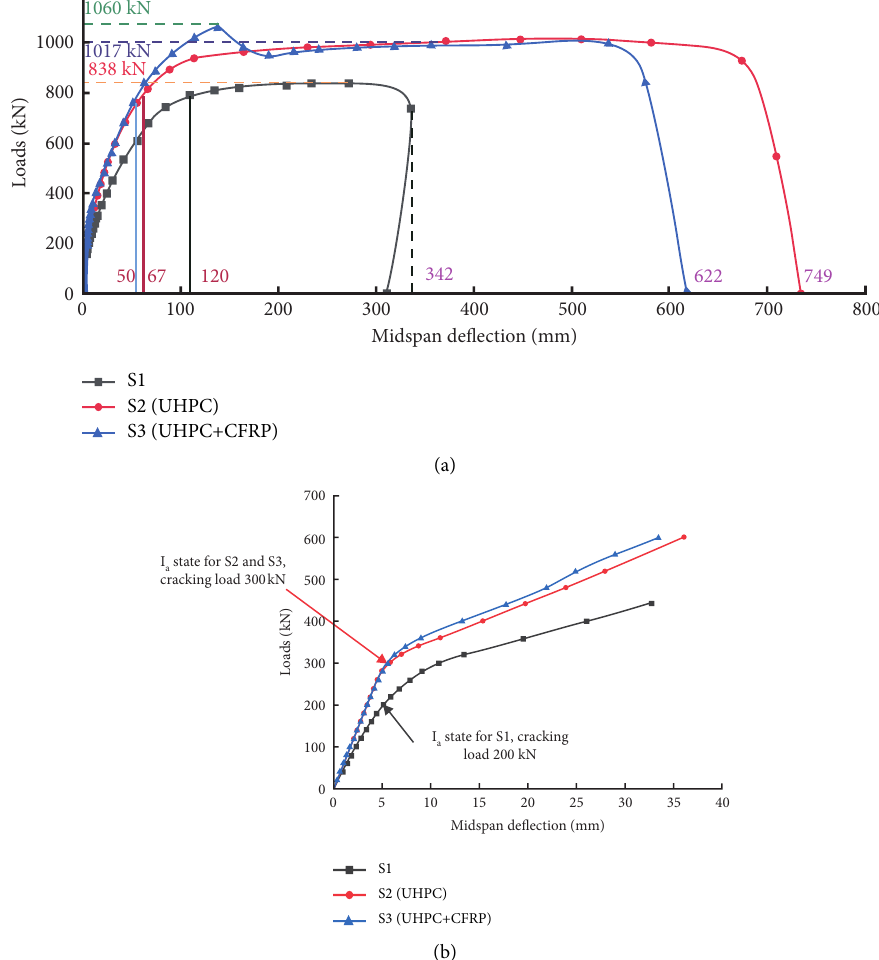
Figure 8: Load-deflection curve in midspan. (a) The whole process of the test. (b) Stage I: uncracked Table 3 neutral axis height), but the neutral axis of sample S1 is lower than that in samples S2 and S3. The neutral axes of samples S2 and S3 are quite close in Figure 10(b), with notably good bonding between the UHPC parts of samples S2 and S3 and the prestressed concrete hollow slab, showing good composite effect, and exceptionally good performance of the composite part.